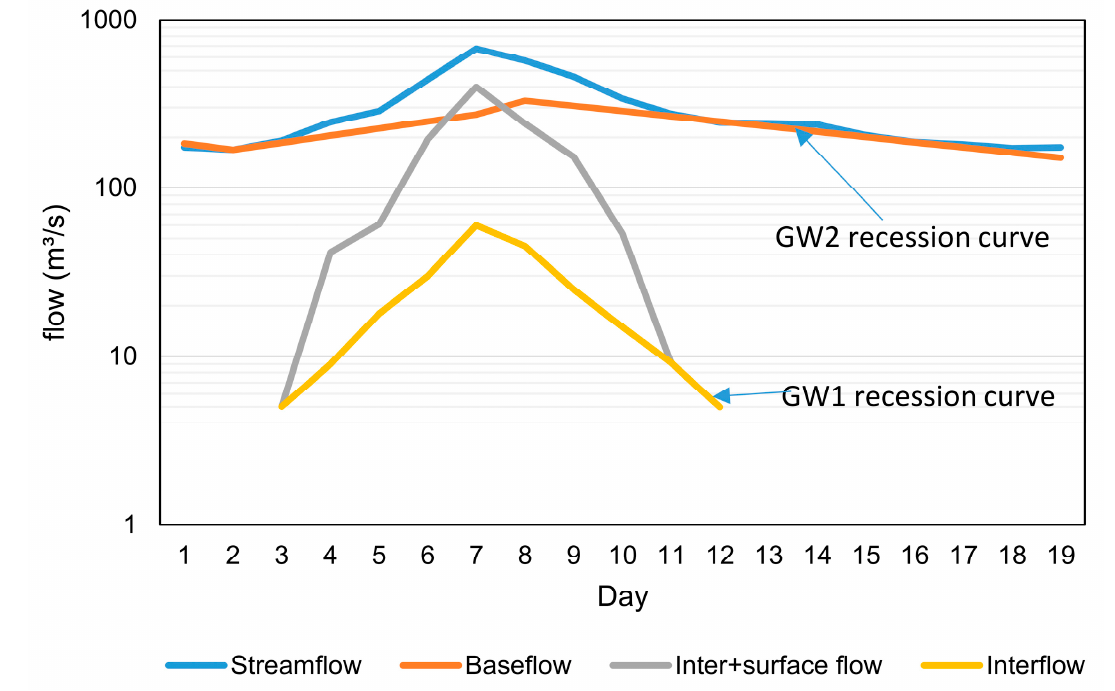
Figure 4. Hydrograph components to estimate recession constant for GW1 and GW2 layers. The impervious surface area was obtained from the NASA Socioeconomic Data and Applications Center [64], which was only 0.09% of the total area of the SYER, and even less (0.03%) has been mapped by Zhang, et al. [65]. Max canopy (Table 3) and surface- depression storages (Table 4) were obtained from the literature, such as Ahbari, Stour, Agoumi and Serhir [54], Samady [60], and Verbeiren, et al. [66], using the vegetation types and basin slope in the region. Vegetation types were extracted using Global Land Cover Characteristics (Table 1), with 88% of grassland, and the slope was extracted using SRTM-DEM (Table 1), ranging from 0% to 185% (17% mean) in the SYER (Figure 3). Table 3. Maximum canopy storage in the headwater of the Yellow River, described in Ahbari et al. (2018), Samady (2017), and Verbeiren et al. (2016).